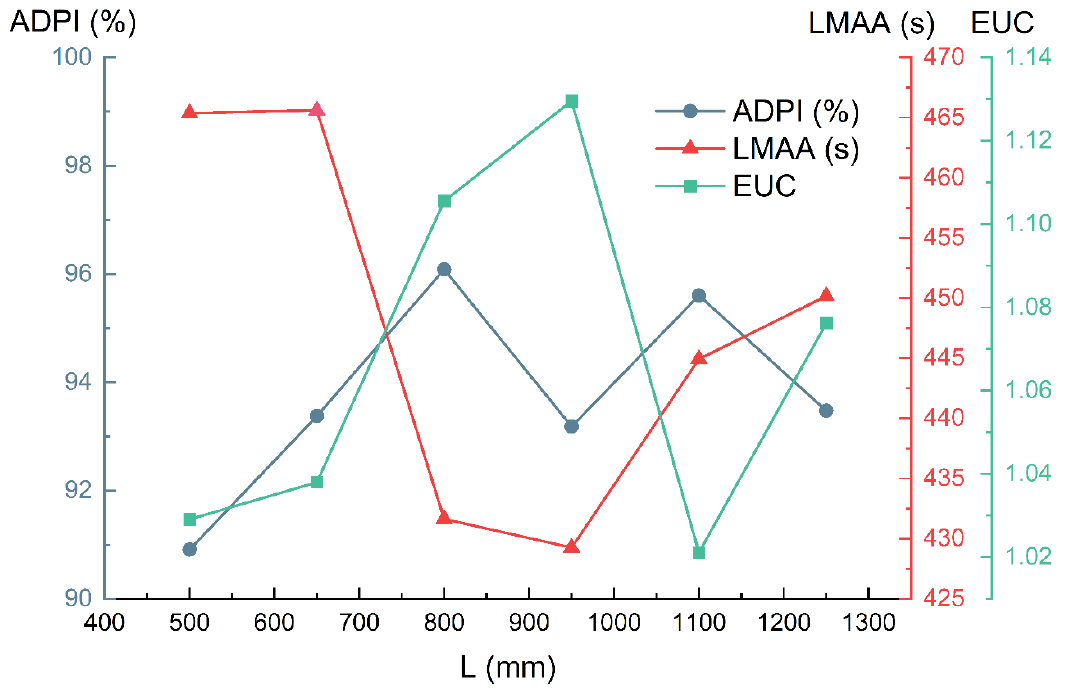
Figure 15. Diagram of ADPI, LMAA, and EUC in the plane z = 1.1 m with different air inlet spacings.